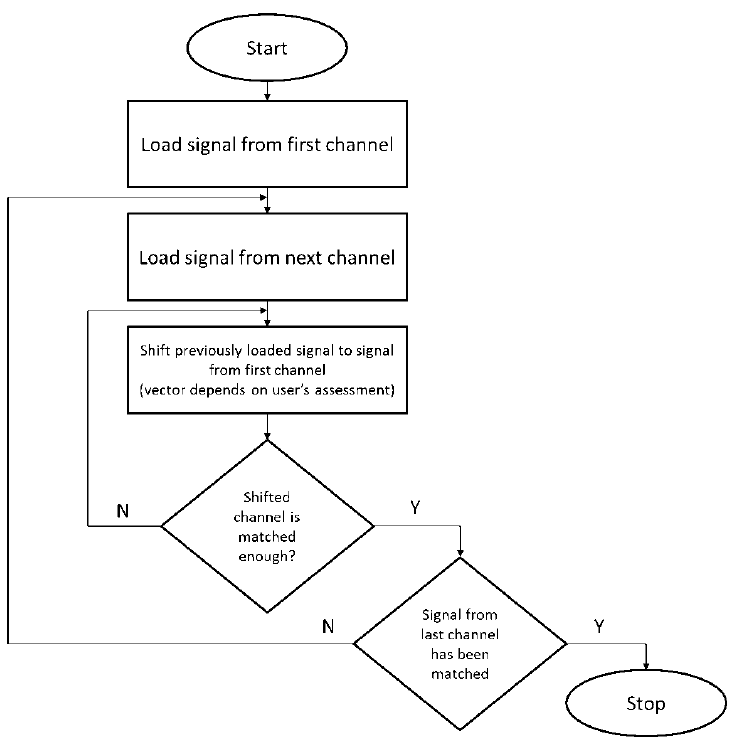
Figure 10. The manual method’s synchronization